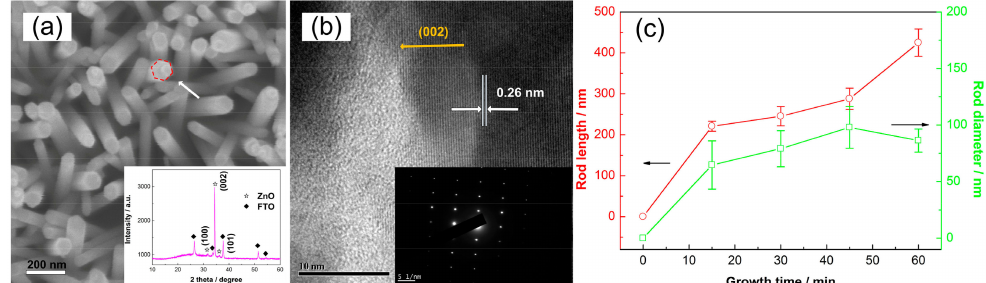
Figure 1. ( a ) SEM top view and XRD pattern (inset) of ZnO NRAs prepared by a hydrothermal reaction; ( b ) high-resolution TEM view and SAED pattern of individual ZnO nanorod; and ( c ) nano-sizes (i.e., rod length and diameter) as a function of the growth durations.